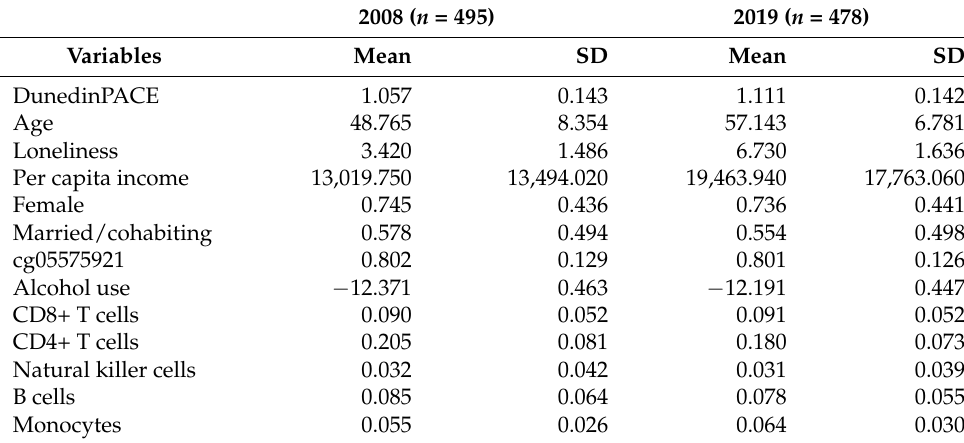
Table 1. Means and standard deviations for study variables.